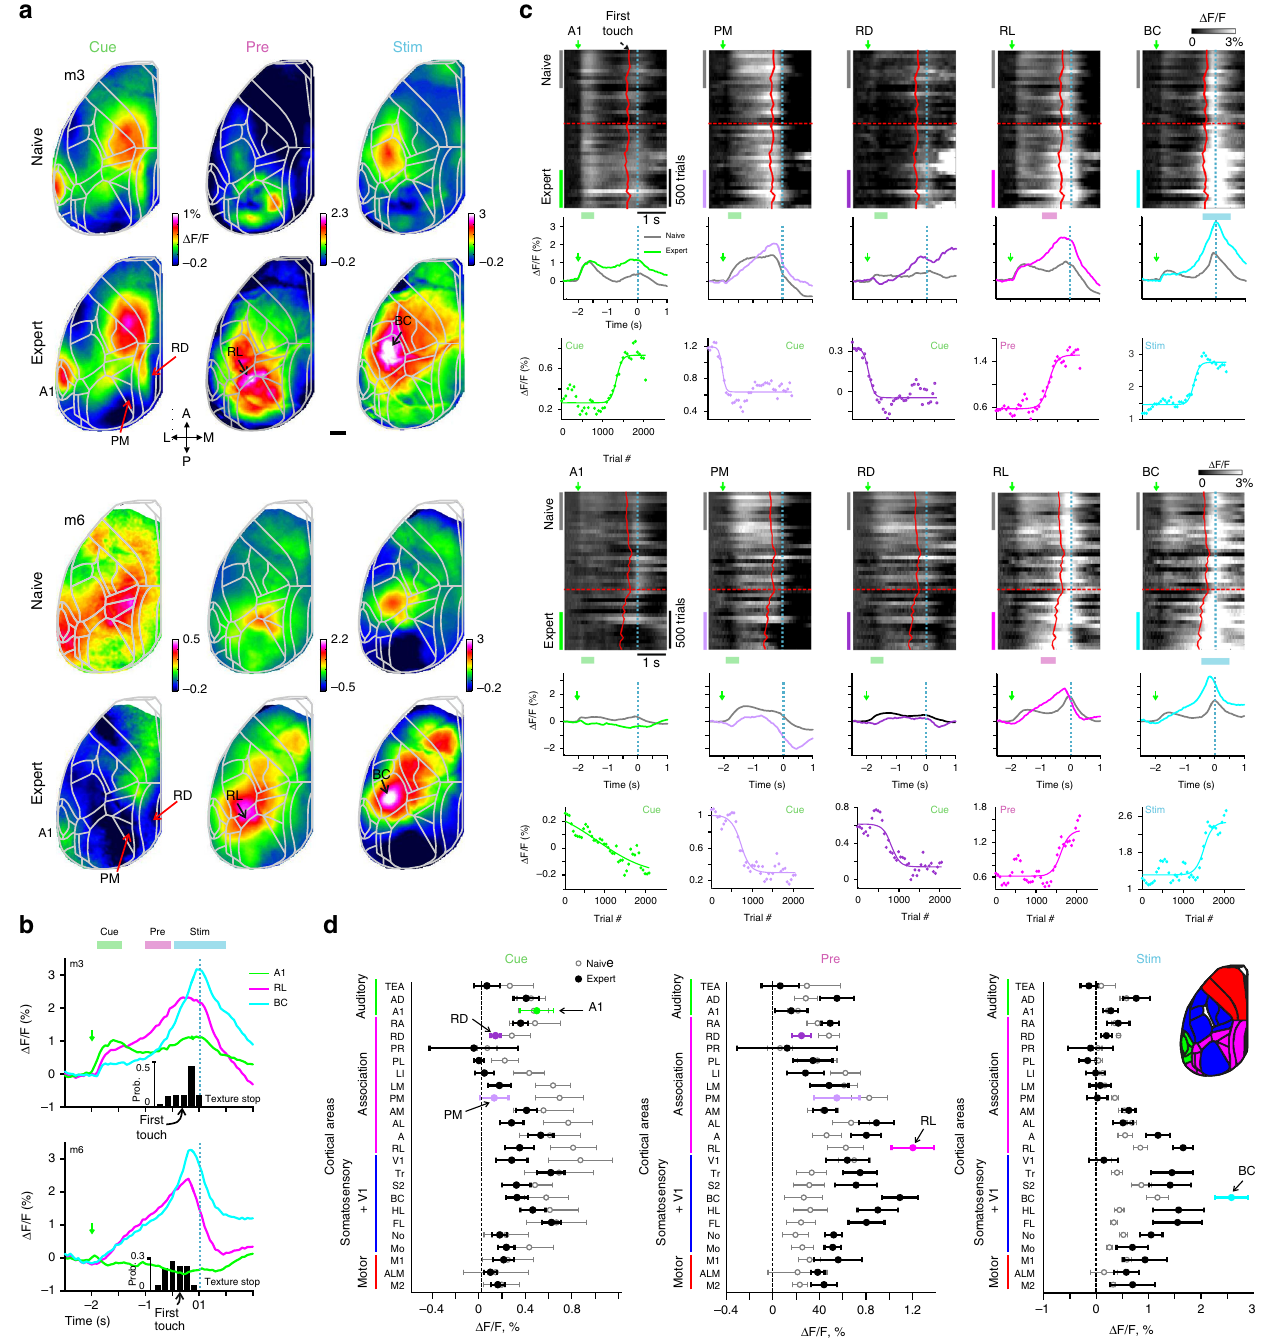
Fig. 3 Changes in wide- fi eld calcium signals across cortex during learning. a Example activation maps from two mice averaged during cue-, pre-, and stim-period in naïve (top) and expert (bottom) phase. Color scale bar indicates min/max of percent Δ F / F . Overlay of areas in gray for all maps. 5 areas of interest are marked. Scale bar is 1 mm. b Expert trial-related average responses in A1, RL, and BC for the two example expert mice. Green arrow marks stimulus cue. Histograms at the bottom indicate distribution of the fi rst touch of the whiskers on the texture. c Continuation of examples in a . Top: population responses plotted for the two temporal scales (trial scale along x -axis; learning scale along y -axis) for fi ve areas of interest (from left to right): A1, PM, RD, RL, and BC. Data is binned every 50 trials. Red lines indicate mean fi rst touch of the whiskers on the incoming texture. Dashed cyan line indicates texture stop. Dashed red line indicates learning threshold. Middle: trial-related area responses for expert (colored) and naïve (gray). Bottom: mean responses across learning for each area averaged during the speci fi c trial period indicated. Each curve is fi tted with a sigmoid function. d Mean activation of all 25 cortical areas in expert (black) and naïve (gray) mice during cue-, pre-, and stim-period and grouped into auditory (green), association (pink), somatosensory + V1 (blue), and motor (red) areas (see also inset). Error bars are s.e.m. across mice ( n =